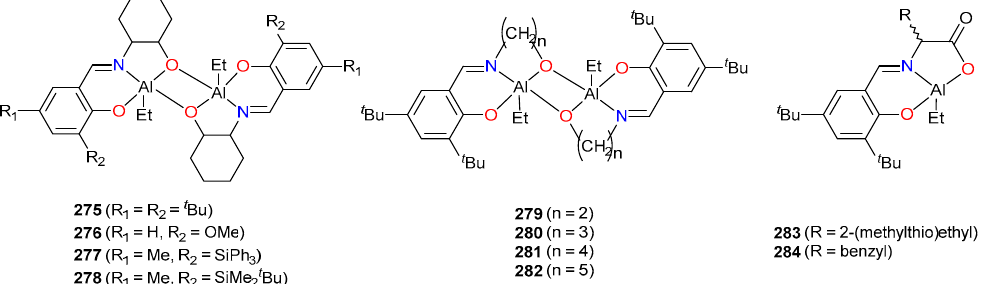
Figure 42. Half-salen aluminum complexes active in the ROP of rac -LA [123].